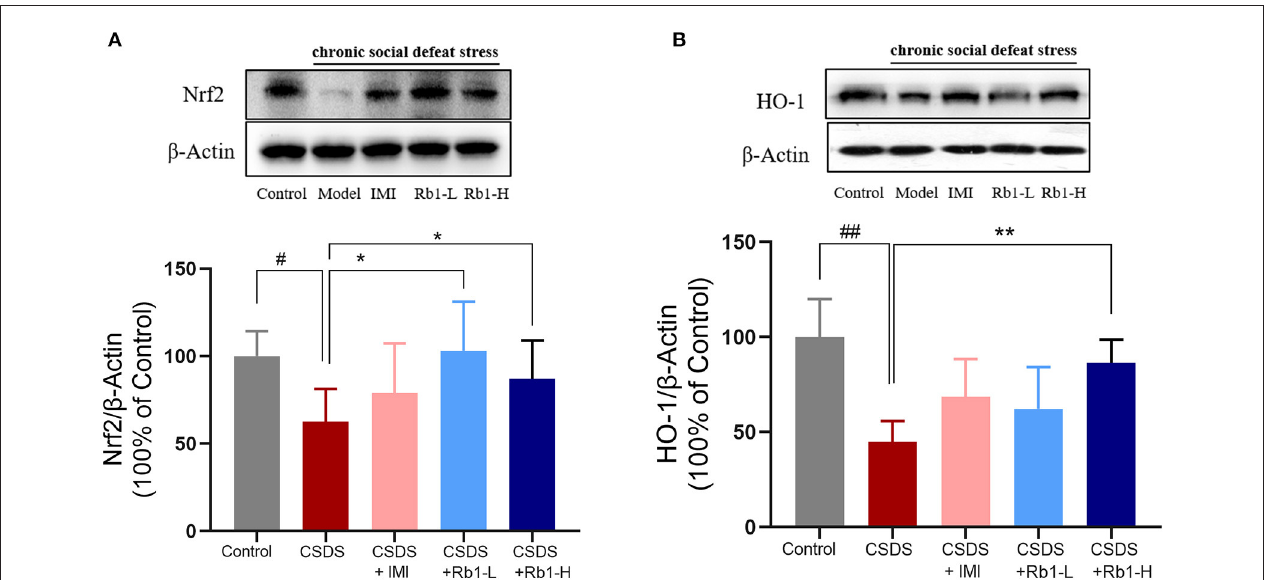
FIGURE 6 | Ginsenosides Rb1 induced NRF2 and HO-1 upregulation in the hippocampus of CSDS mice. Western blots analysis illustrates (A) NRF2; (B) HO-1. The entire data has been presented are means ± SEM; N = 4 mice/group. # p , and ## p < 0.05, and 0.01, accordingly, considerably different from control; * p , and ** p < 0.05, and 0.01, significantly varied from CSDS